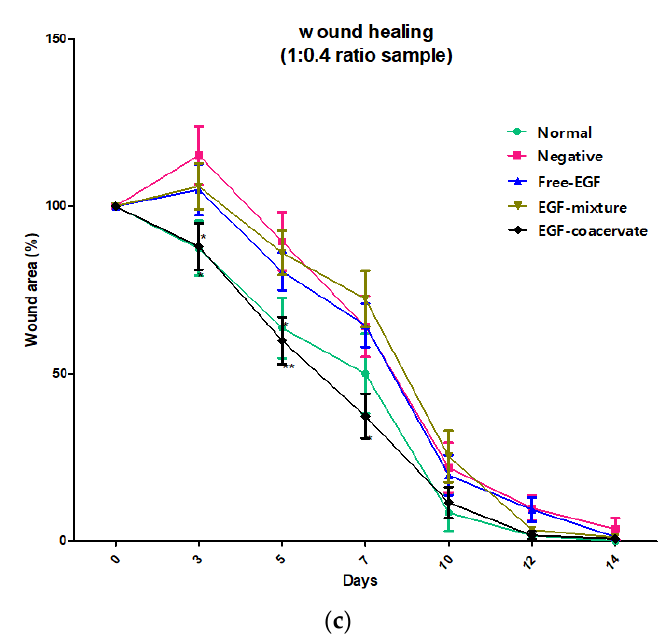
Figure 3. Effect of EGF-Coa on full-thickness excisional wounds in streptozotocin (STZ)-induced diabetic mice model compared to normal mice. ( a ) In vivo application of freeze-dried EGF-coacervate to the wound site. ( b ) Representative photographs of ① Normal: wound sites in normal mice treated with Dulbecco's phosphate buffered saline (DPBS), ② Negative: wound sites in STZ diabetic mice treated with DPBS, ③ Free-EGF, EGF-PM, and EGF-coacervate: wound sites in STZ diabetic mice treated with EGF solution, EGF-PM, and EGF-coacervate. ( c ) Average and standard deviations of wound area over time, measured as the percentage of the wound area at time 0. The results are shown as combined data from Method 2.3 (0, 3, 5, 7 days, n = 10) and (0, 3, 5, 7, 10, 12, 14 days, n = 5). * p < 0.05, ** p < 0.01. Two-way ANOVA was done with GraphPad Prism software.